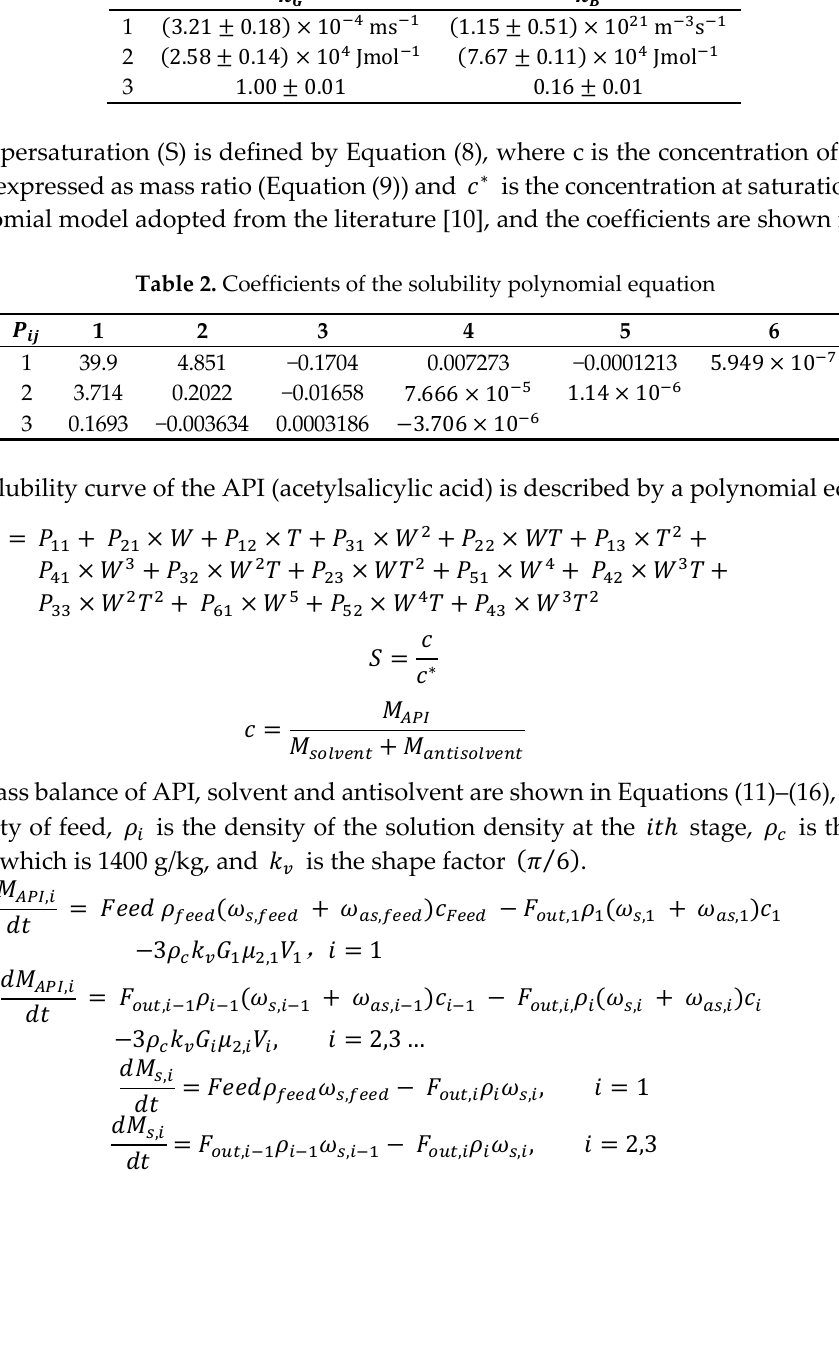
Table 1. 𝑘 (cid:3008)(cid:3036) and 𝑘 (cid:3003)(cid:3036) are empirical parameters. 𝒌 𝑮 𝒌 𝑩